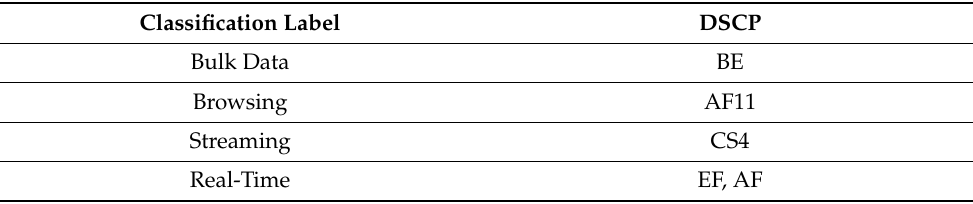
Table 6. Classification category and DSCP tag correspondence. Classification